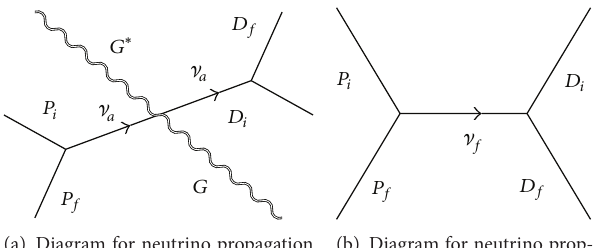
Figure 2: Shown are diagrams of neutrino propagation in the quantum field theoretical description (such as found in [22]). The neutrino is described as a stretched propagator between the production ( 𝑃 ) and detection ( 𝐷 ) (b) weak processes (with initial and final states denoted by subscripts 𝑖 and 𝑓 ). In the case of quantum decoherence (a), the emission of a graviton in between the production and detection processes means that the neutrino exists in a definitive mass state since both the propagation Hamiltonian and graviton interaction Hamiltonian conserve mass. The quantum decoherence effect described here follows from the discussion in Section 2 of